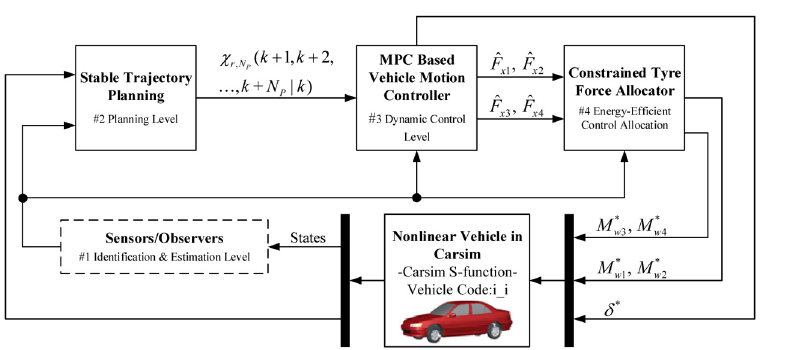
Figure 7 Structure of the proposed control system